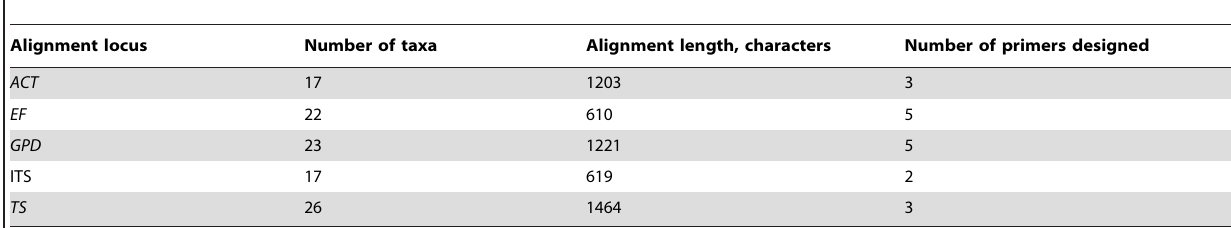
Table 2. Details of DNA sequence alignments used for primer design, including the numbers of taxa, alignment lengths and the numbers of primers designed at each